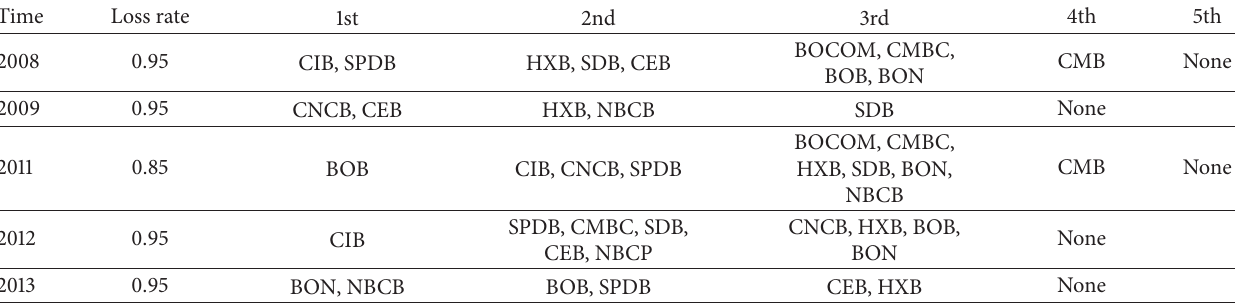
Table 2: BOC as the source of risk contagion.